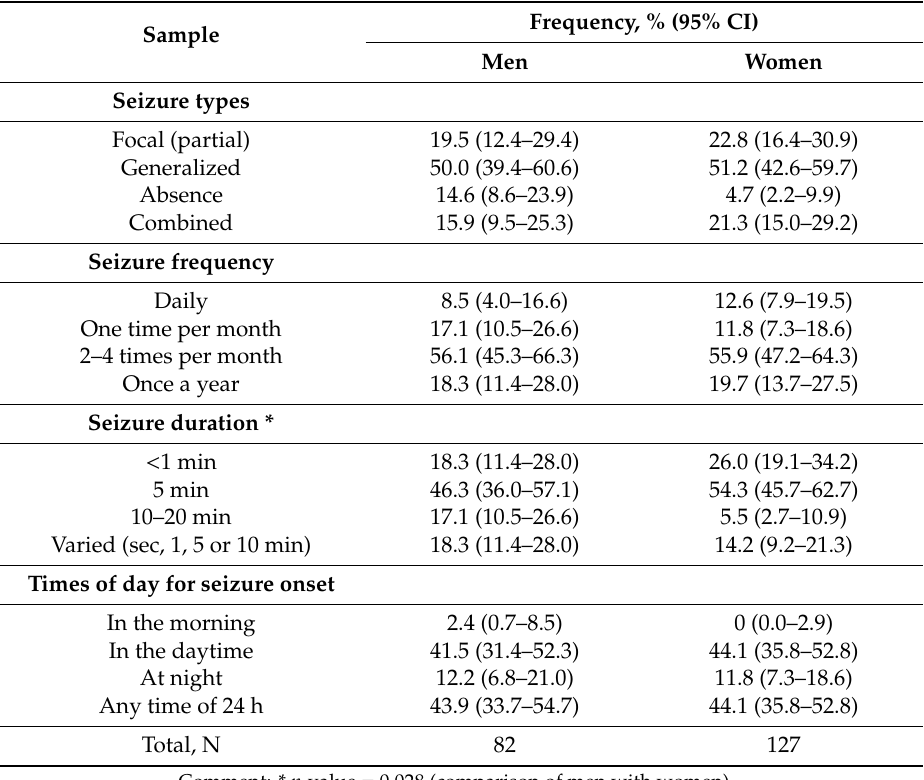
Table 7. Clinical characteristics of seizures in patients with